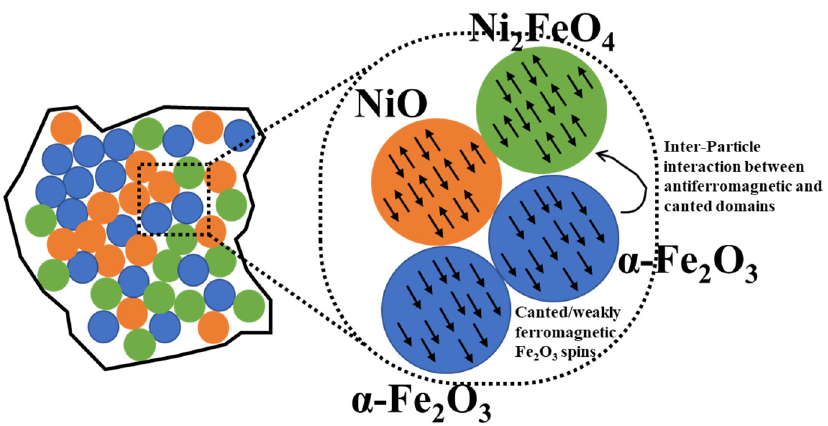
Figure 6. Schematic illustration of spin interactions that may have taken place inside the magnetic domains of the different components consisting variable spin functionalities.